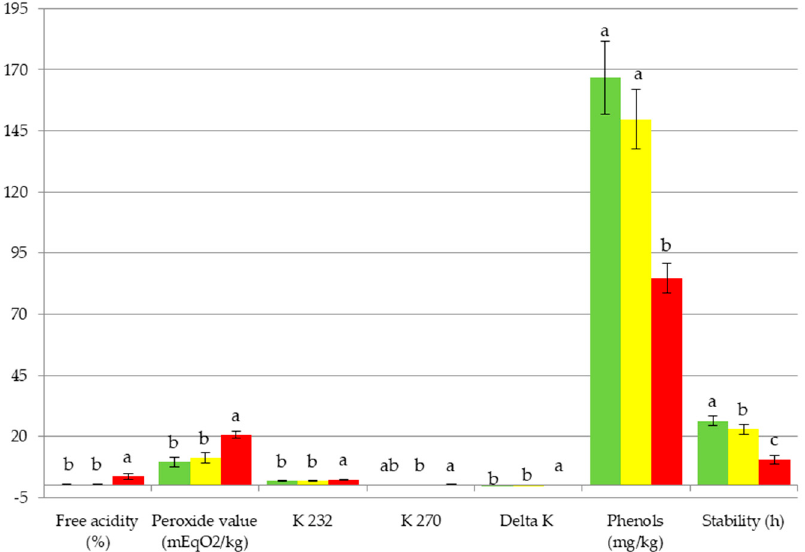
Figure 1. Mean values and standard deviation for the chemical and physical-chemical parameters over the six week period for the Organic ( ), Conventional ( ) and Ground ( )